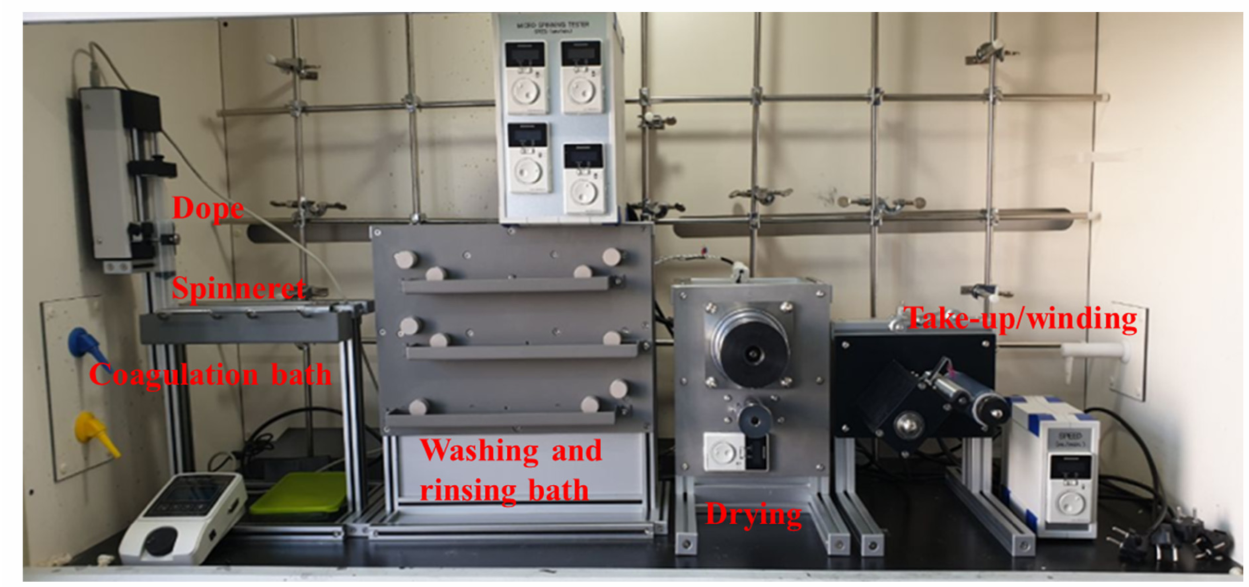
Figure 2. Lab-scale wet spinning equipment and spinning process. The spun PAN fiber was stretched 10 times through a dry or wet drawing process, and the stretching ratio was uniformly stretched at a slightly lower value than that of the actual carbon fiber precursor manufacturing process, such that the drawing process could be compared without other factors. Wet-spun PAN precursor fibers stretched 15–25 times generally. In comparison, this study used about half of the drawing ratio. The drawing equipment is shown in Figure 3, where for dry drawing, 1000% of the drawing was performed over three stages at 130 ◦ C after preheating at 70 ◦ C. The wet drawing conditions were preheated in the first bath, followed by multistage stretching from the second bath onwards, and the temperature of each bath was 80, 85, 85, 90, 90, 90 ◦ C. Thereafter, each fiber was naturally dried without any post-treatment after stretching and stored at room temperature. As mentioned before, in the spinning process, 50% of natural stretching was performed to maintain the tension in the washing, drying, and winding processes, and thus, the final fiber was stretched by 1500%.